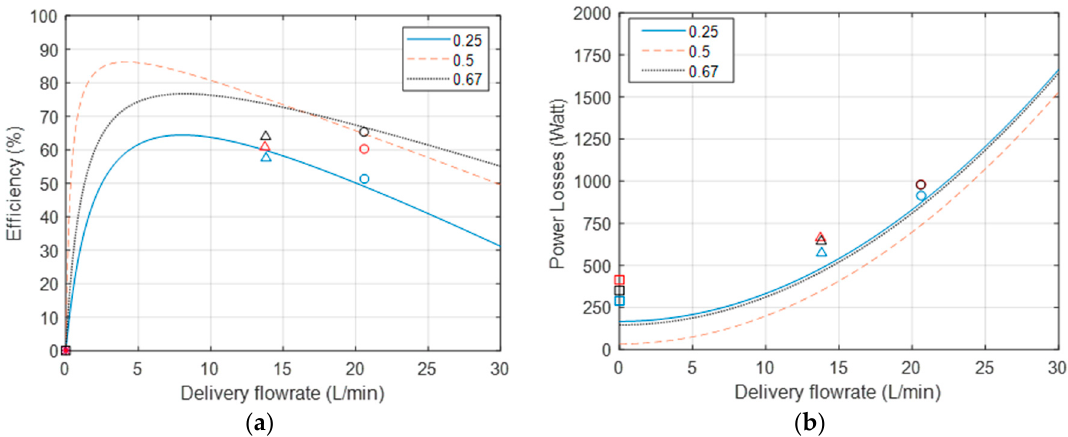
Figure 7. Experimental and analytical efficiency and power loss of a flow booster. ( a ) Efficiency versus delivery-flow rate; ( b ) power loss versus delivery flow rate.